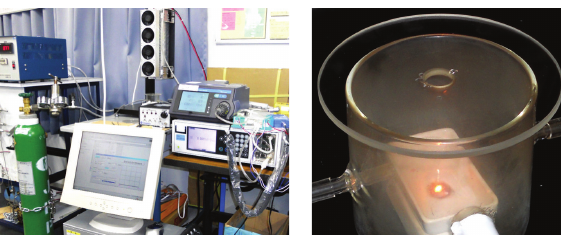
Figure 7: Initial coal temperature gradient versus laser